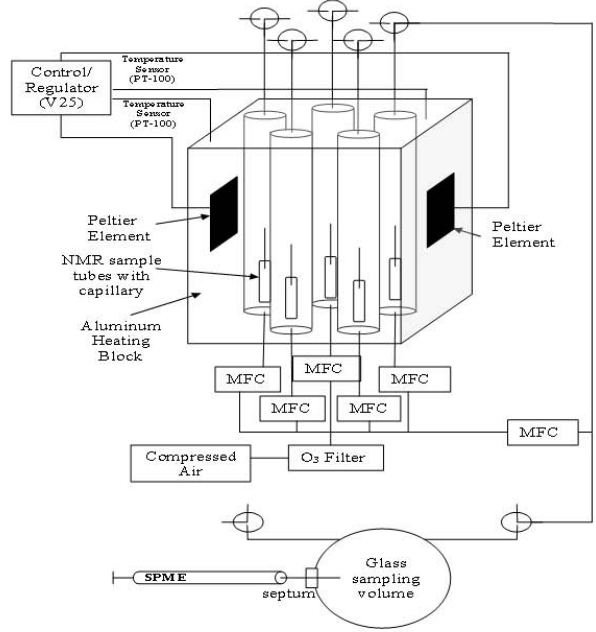
Fig. 1. Schematic representation of capillary diffusion system (CDS) and glass sampling chamber. Aluminum block is maintained at 27 ◦ C by either heating or cooling the peltier elements. Entire aluminum block is surrounded by a thick layer of insulation mate- rial and peltiers are connected to large cooling vanes to effectively dissipate heat. Tubing leading to the glass chambers is pre-heated to equilibrate air temperature prior to entry into the glass cham- ber. MFC: mass flow controller. V25: a MPI custom built con-